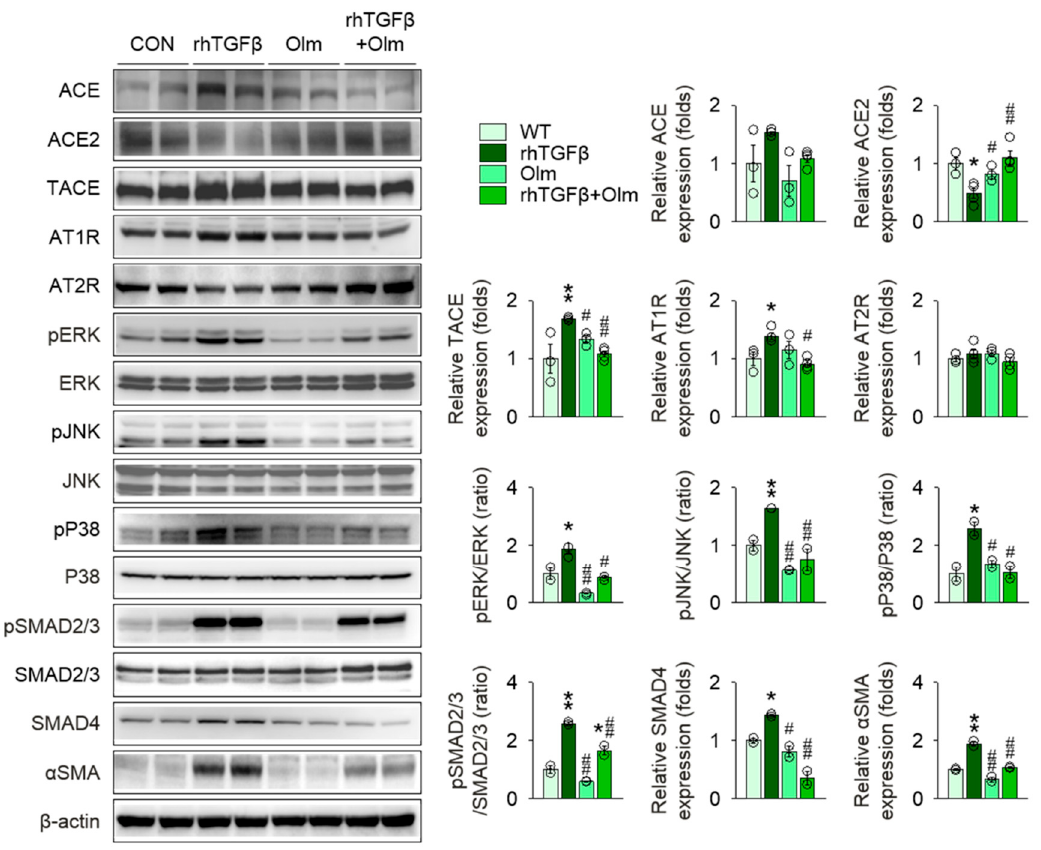
Figure 7. Olmesartan alleviates RAS activation in HK-2 cells stimulated with TGF β . Comparison of protein expression level for RAS components, MAPKs, and downstreams of TGF β in HK-2 cells. Cells were treated with vehicles, recombinant human TGF β (rhTGF β ), Olmesartan medoxomil (Olm), or combination of rhTGF β and Olm. ( n = 3 − 4/group). Data are representative of more than three independent experiments. * P < 0.05, ** P < 0.01 versus vehicle group; # P < 0.05, ## P < 0.01 versus rhTGF β group by one-way ANOVA with Newman–Keuls multiple comparison test.